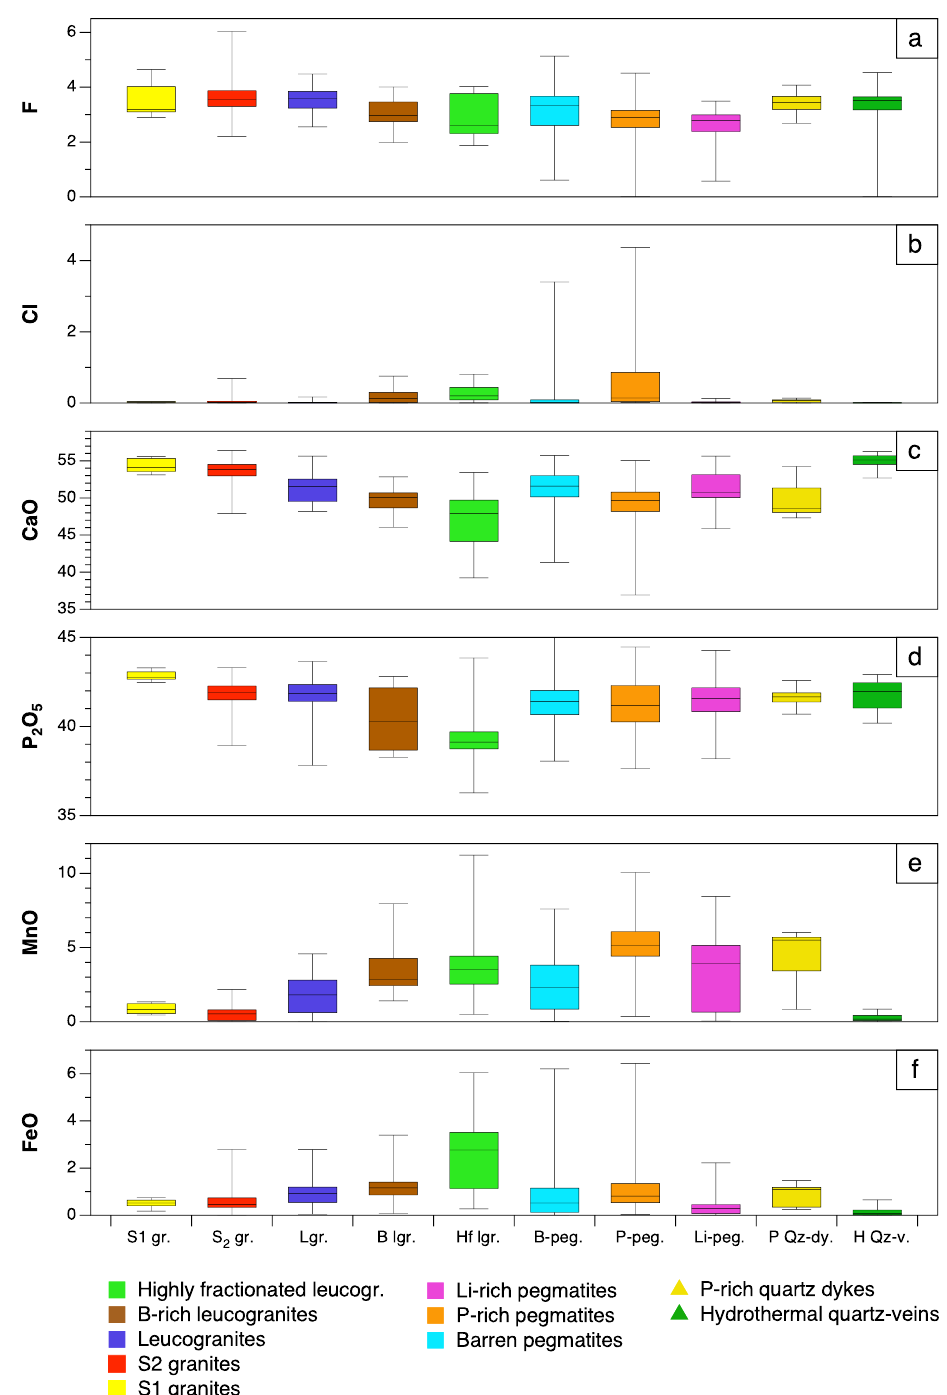
Figure 2. Box and whisker plots for major and minor elements in apatite from the different lithologies. All values in wt.%.